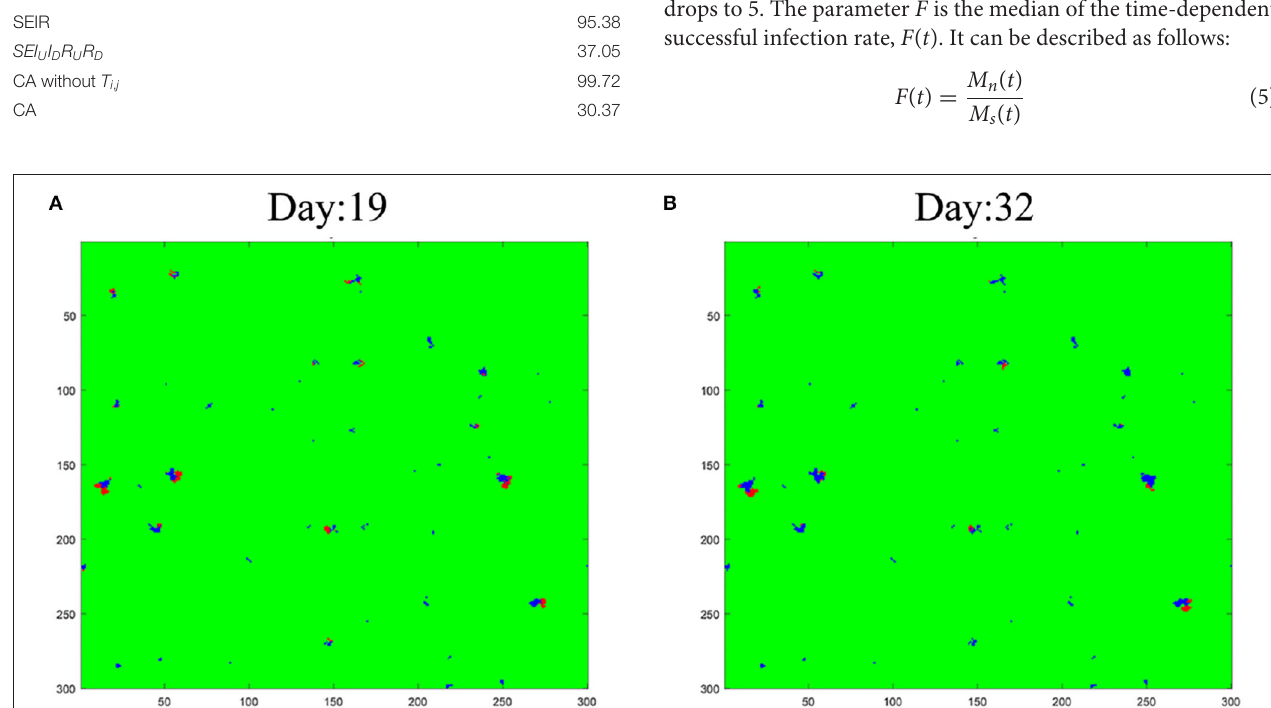
Frontiers in Public Health |